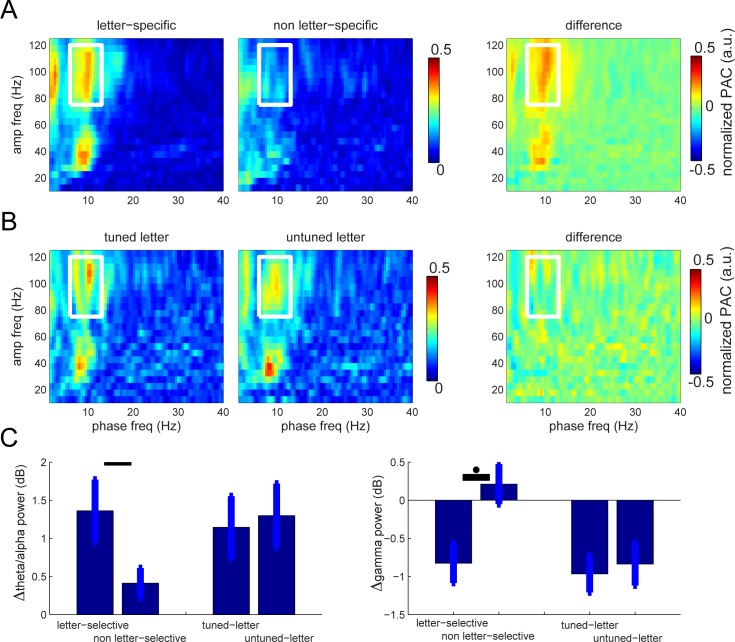
Properties of PAC during maintenance.(A) Average (14 sites) PAC is greater at letter-selective than at non-letter-selective sites. In right panel, differences were calculated for each subject; the average difference is large, showing that PAC is much larger at letter-selective sites (p < 0.012). (B) Average (14 sites) PAC is somewhat larger for tuned compared to untuned letters. In panel at right, difference for each subject was calculated before averaging. This difference was not statistically significant. (C) There is a significant difference (two-tailed t test; p = 0.012) of gamma power between letter-selective sites and non-letter-selective sites during the maintenance period. There is no significant difference between theta and gamma power over letter-selective sites when comparing the tuned letter and untuned letter during the maintenance period. Underlying data available at http://orion.bme.columbia.edu/jacobs/data/. a.u., arbitrary unit; PAC, phase–amplitude coupling